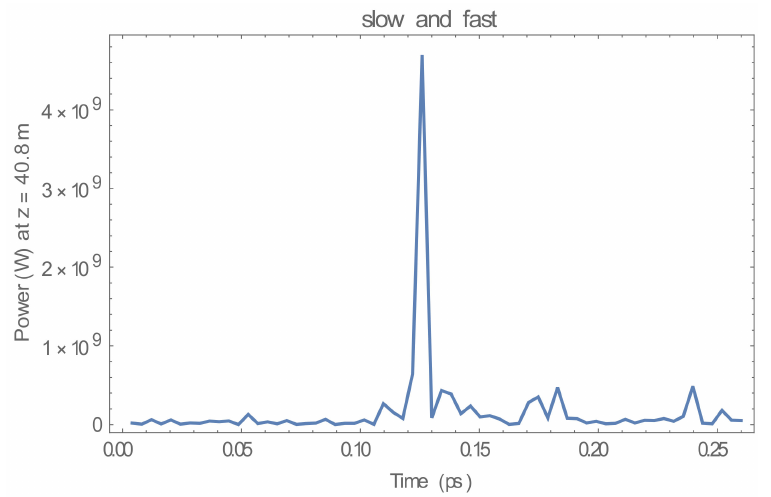
Figure 12. The temporal pulse shape at z = 40.8 m for the sum of the fundamental and the higher- order modes of h = 1, 3, and 5 modes in the two-beam system with the elliptically polarized undulator (color